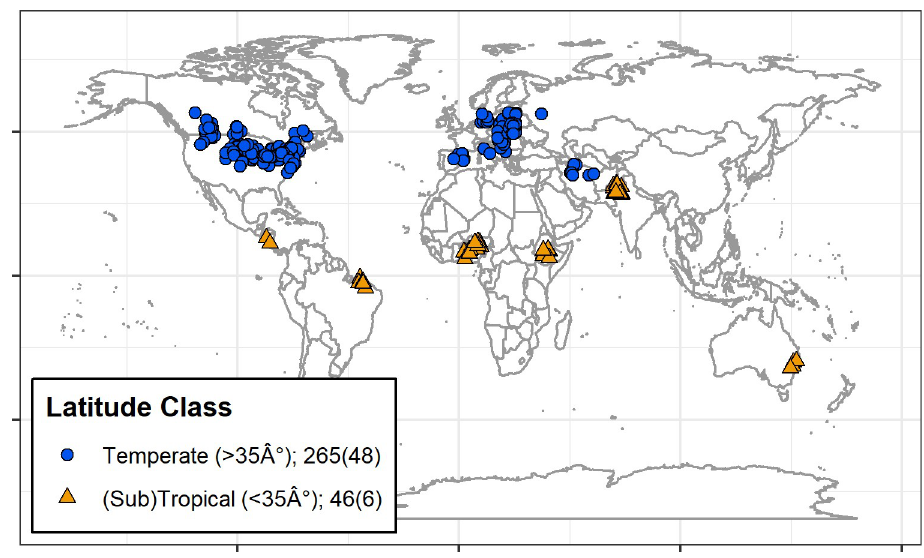
Fig 1. Map of meta-analysis study locations. Temperate (blue circles, > 35˚ latitude) and sub-tropical/tropical (orange triangles, < 35˚) study locations with number of data points and number of studies (in parentheses) for each latitude